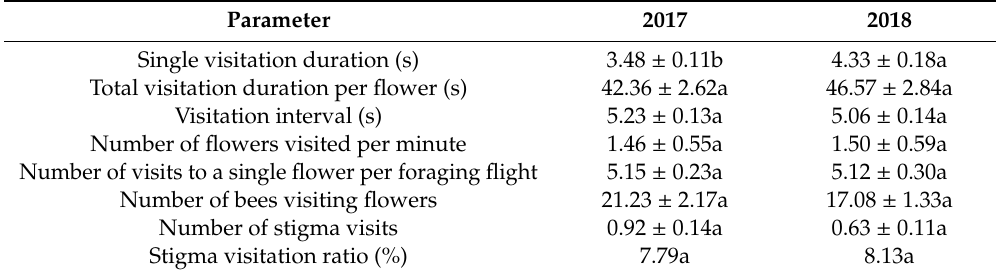
Table 1. Foraging behaviors of A. mellifera on the oil tree peony ‘Feng Dan’ in di ff erent